Question: Which kind of chart has been used to present this data?
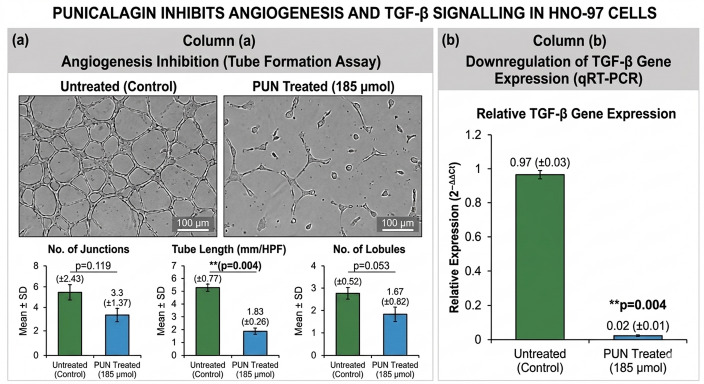
Answer: bar